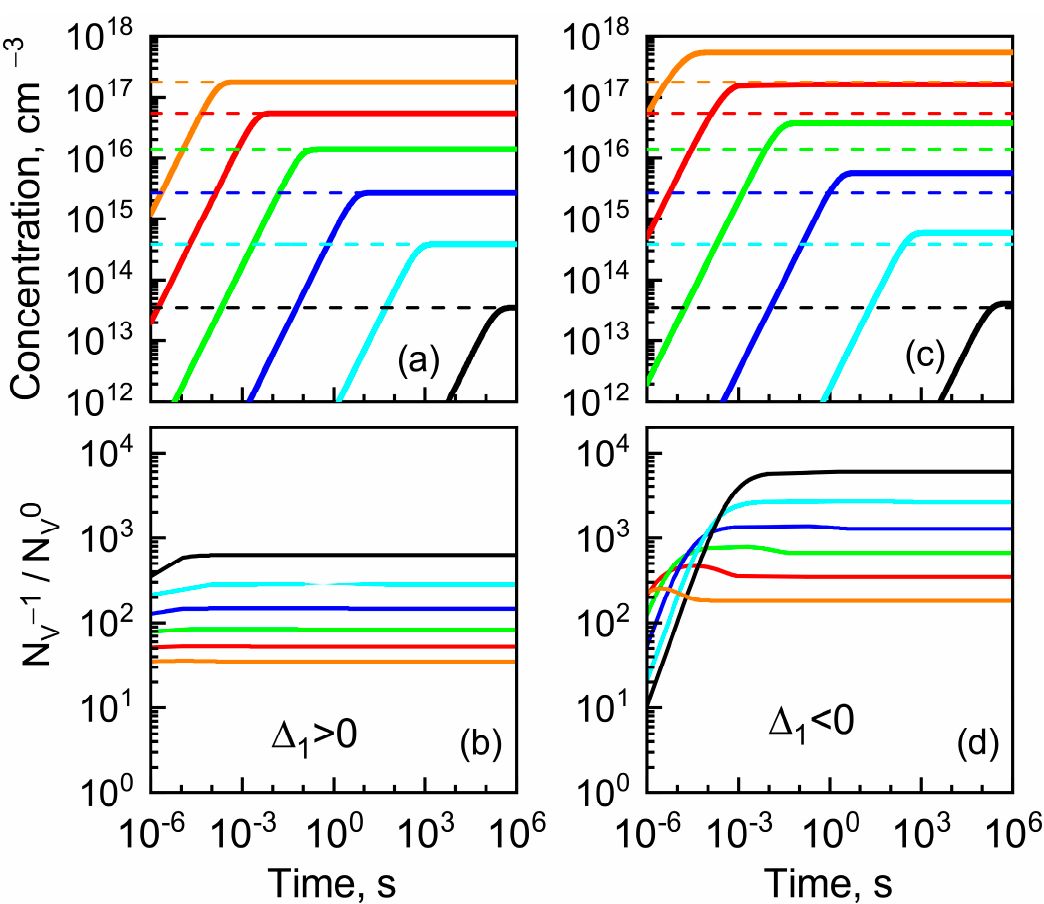
Figure 4. Dynamics of charged vacancy concentration ( a , c ) and ratio of charged to neutral vacancy concentrations ( b , d ) calculated for different temperatures: 900 K (black), 1000 K (cyan), 1100 K (blue), 1200 K (green), 1300 K (red), and 1400 K (orange), with H 0 f m = 3.7 eV and = 2.7 eV for cases ( a , b ) ∆ 1 > 0 ( m hh / m e = 4) and ( c , d ) ∆ 1 < 0 ( m hh / m e = 50). Colored dashed lines related to the corresponding temperature mark of the equi- librium concentration of neutral vacancy.